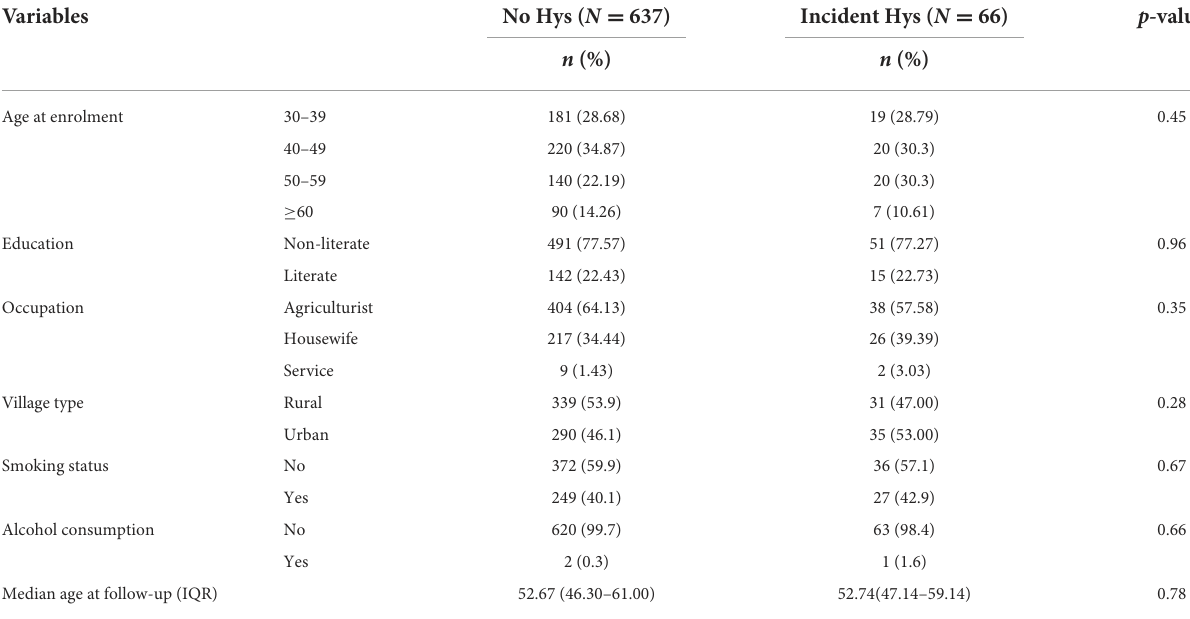
TABLE 1 Distribution of baseline socio-demographic variables among women with no history of hysterectomy and incident hysterectomy.